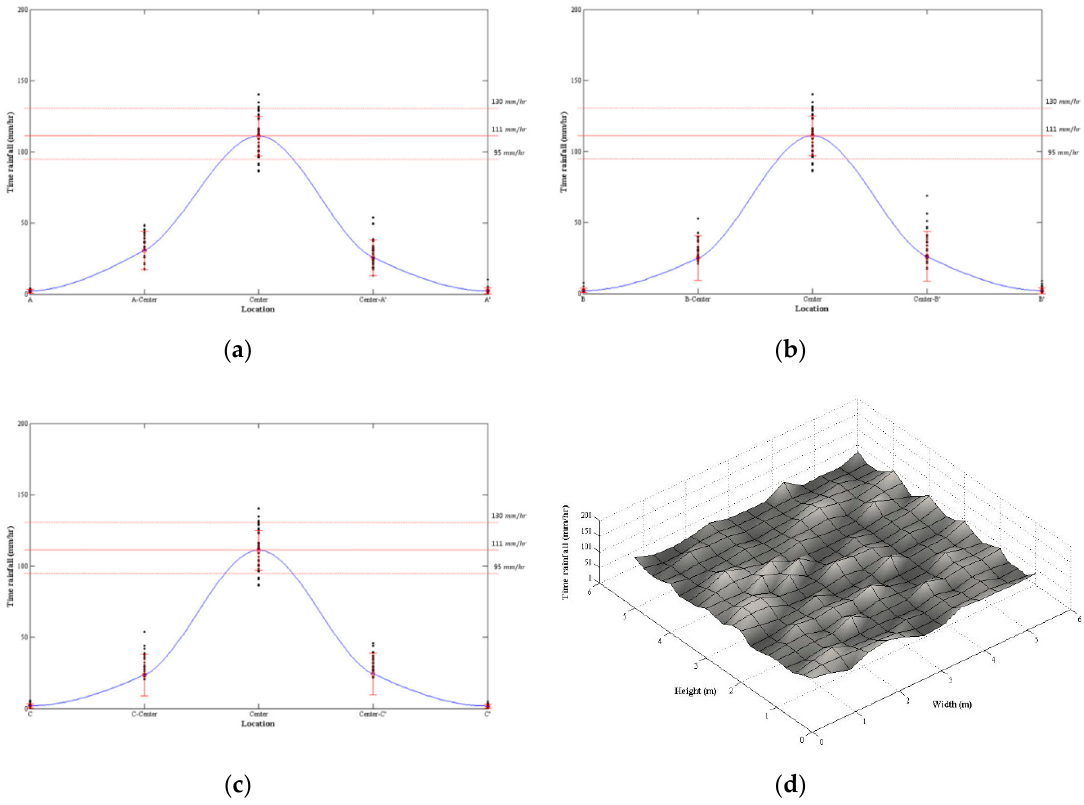
Figure 3. Results of the uniformity tests: ( a ) Sec. A-A ′ for single nozzle test; ( b ) Sec. B-B ′ for single nozzle test; ( c ) Sec. C-C ′ for single nozzle test; ( d ) rainfall distribution for entire area.